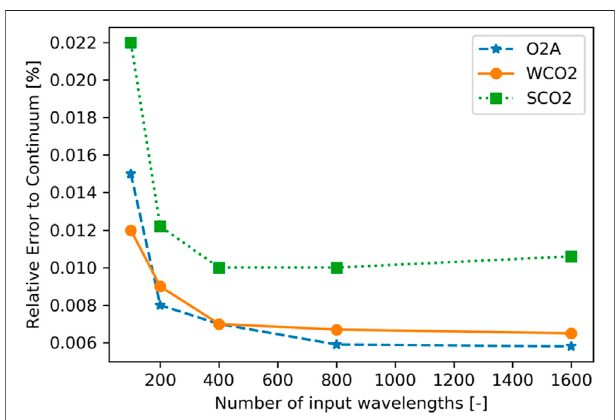
FIGURE 5 | Modeling error in percent relative to continuum for different number of input wavelengths. O2A-band is shown with blue stars, WCO2- band with orange dots, and SCO2-band with green squares.